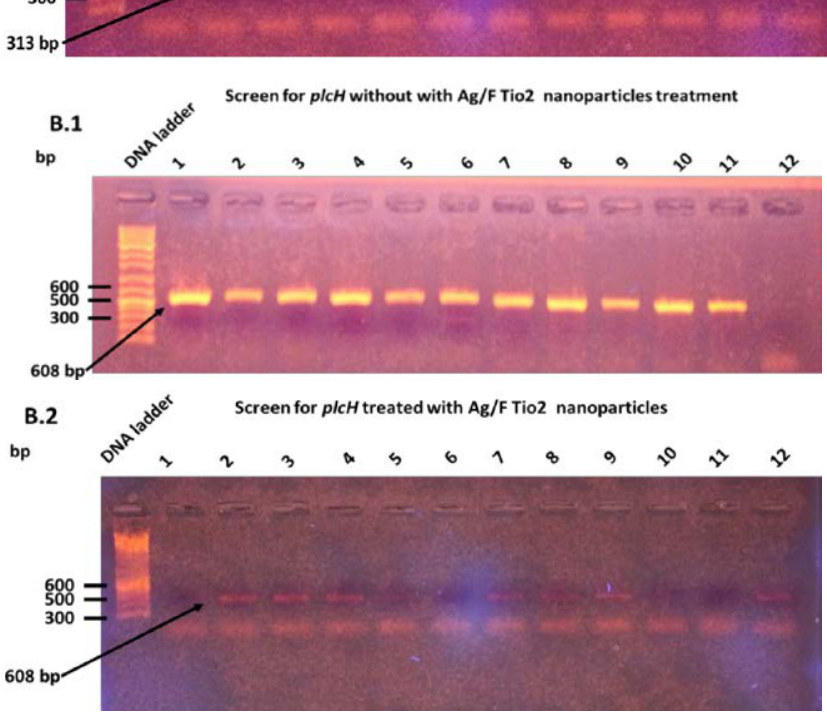
Fig. 3. PCR amplification of both algD and plcH genes P. aeruginosa isolated from patients with Cystic Fibrosis. before and after Ag/F Tio2 treatment. A.1: PCR amplification of algD , showing amplified the predicted product of 313 bp. A.2: The algD gene amplification after Ag/F Tio2 treatment showing the Ag/F Tio2 nanoparticles effect on algD gene amplification. B.1: The plcH gene amplification showing amplified the predicted product of 608 bp. B.2 The plcH gene amplification after Ag/F Tio2 treatment showing the Ag/F Tio2 nanoparticles effect on plcH gene amplification. DNA ladder: molecular weight: 100–10000